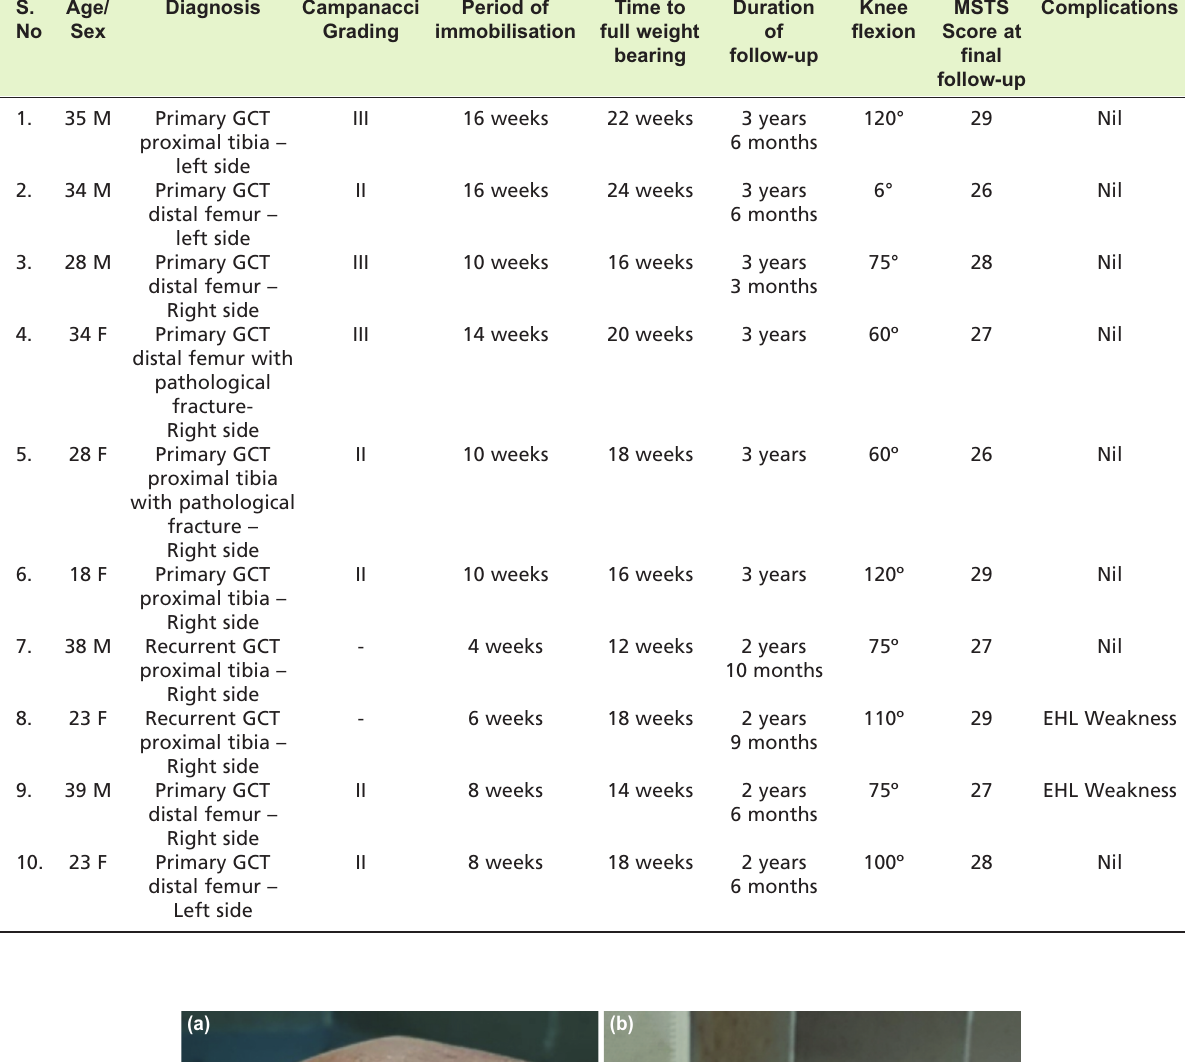
Master chart summarising the findings of the study. Table I: